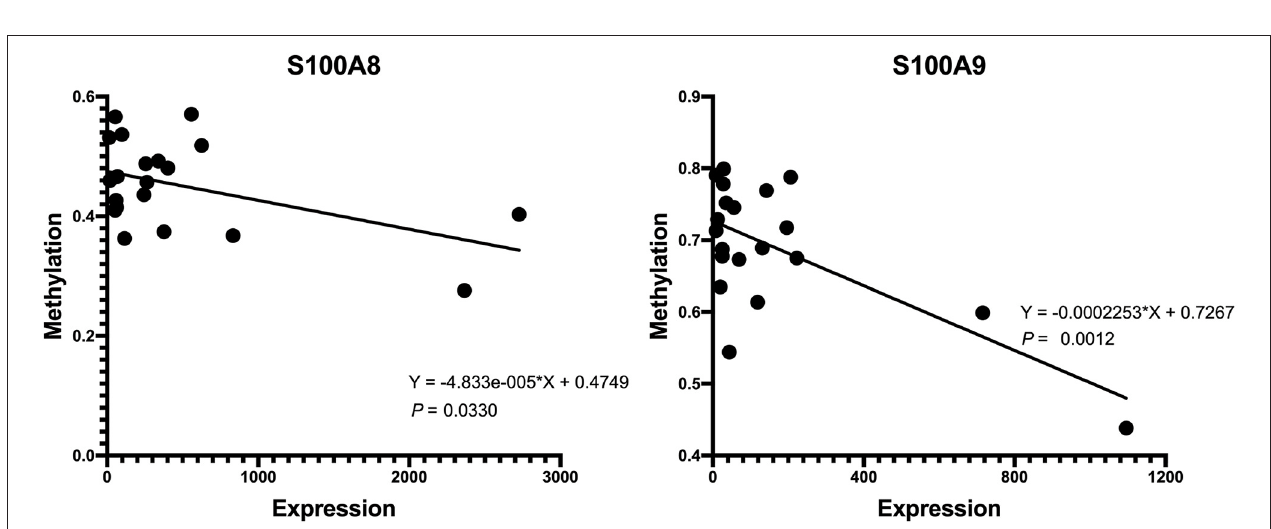
FIGURE 7 | Correlation analysis of DNA methylation and mRNA